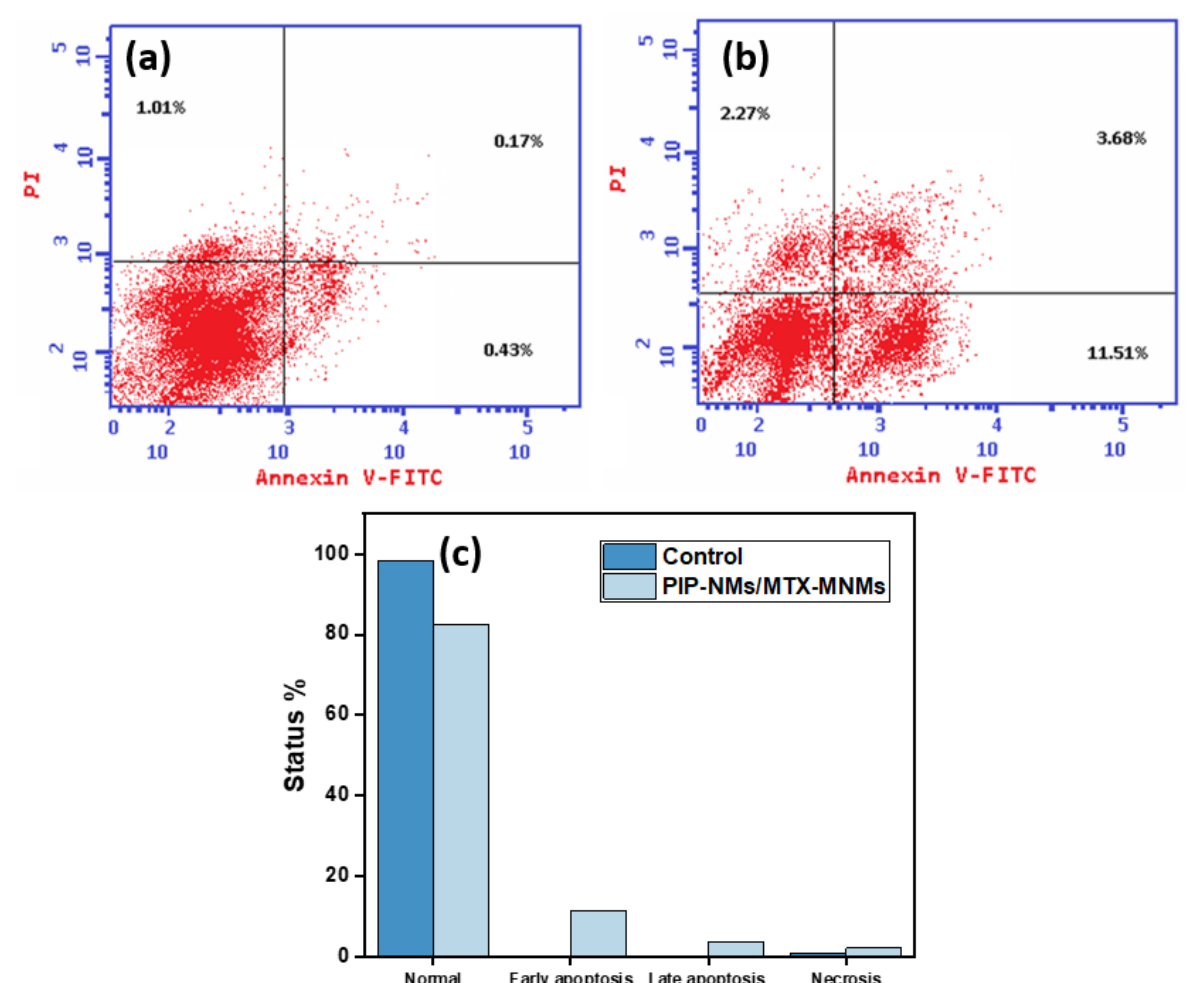
Figure 6. ( a , b ) Cytograms illustrating the induced cell death in ( a ) untreated MCF-7 cells as a control and ( b ) MCF-7 cells treated with PIP-NMs/MTX-MNMs using the IC 50 obtained at 24 h, and ( c ) the cell death percent attained at the early apoptosis, late apoptosis and necrosis of the PIP-NMs/MTX-MNMs combination as compared to the untreated MCF-7 control cells. Cell cycle analysis was performed to investigate the cell cycle kinetics induced by PIP-NMs/MTX-MNMs using the IC 50 at 24 h as compared to the untreated MCF-7 cells as negative control (Figure 7). At the G0/G1, the investigated PIP-NMs/MTX-MNMs combination decreased the cells population from 59.26% to 55.47%, while the population decrease attained in the S phase was of a lower magnitude (from 27.55% to 25.86%) with p = 0.0027 and 0.0417, respectively. In the G2/M phase, the PIP-NMs/MTX-MNMs